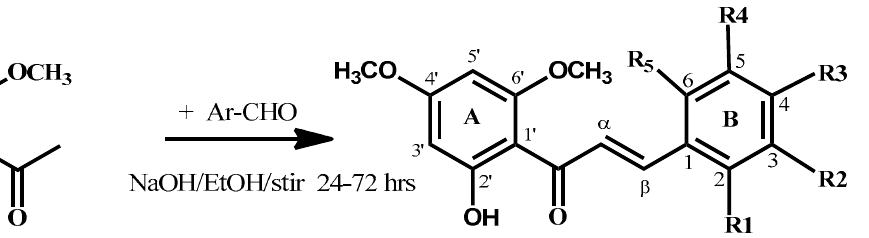
Table 2. IC 50 values ( μ g/mL) of FKB derivatives after 72 h